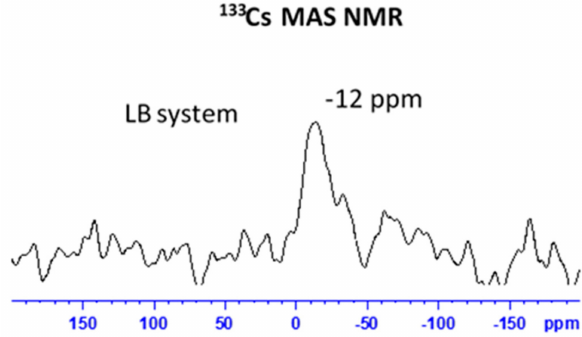
Figure 7. 133 Cs MAS NMR spectrum of LB system after Cs +